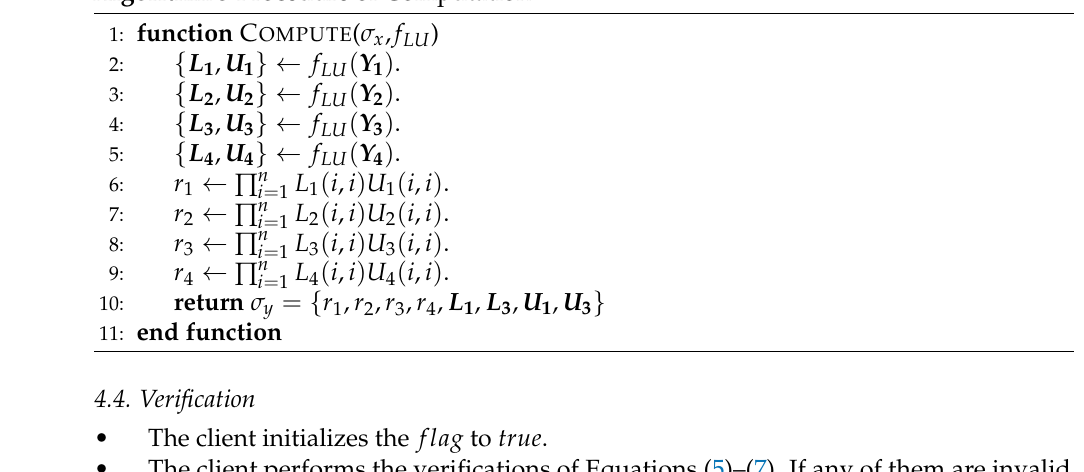
Algorithm 3 Procedure of Computation